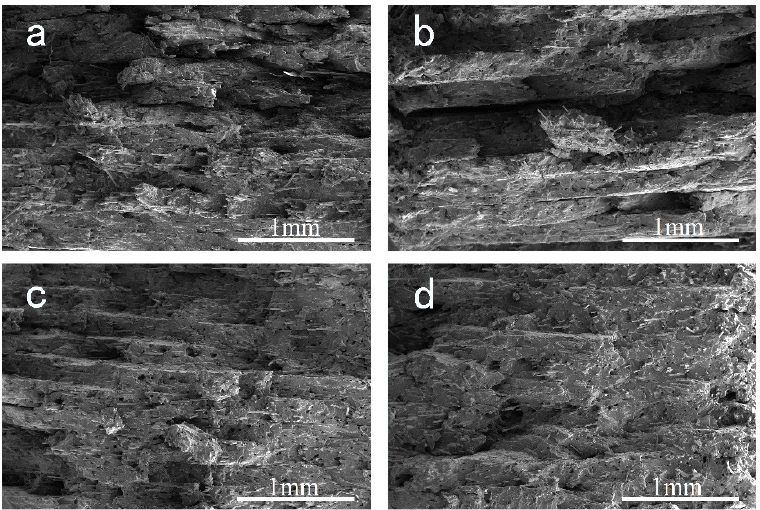
Figure 9. Cross section morphology with low magnification of cryo-fractured samples of ( a ) S-1; ( b ) S-2; ( c ) S-3; ( d ) S-4. The magnification is 130.